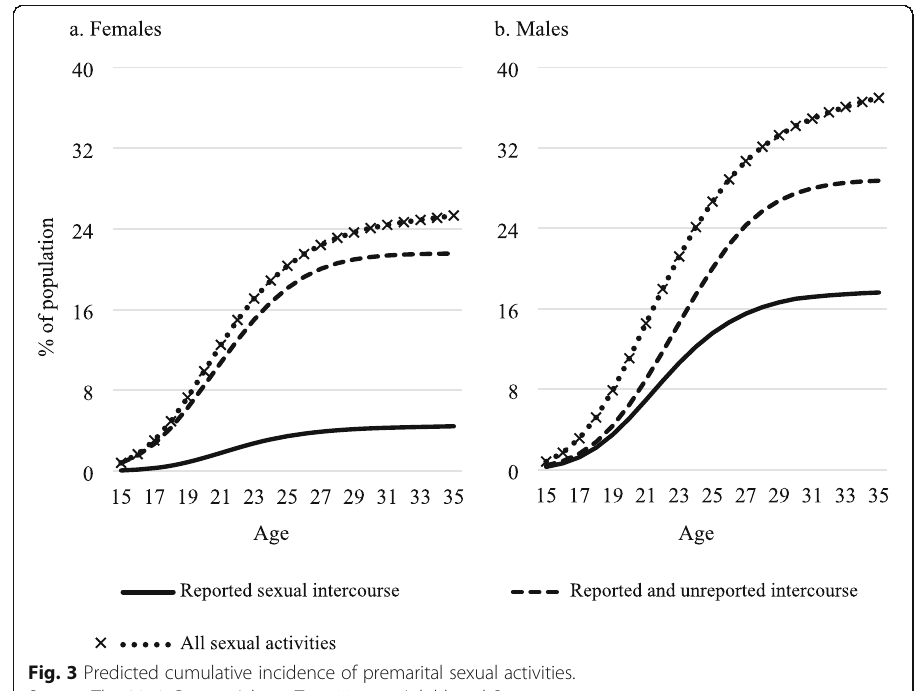
Fig. 3 Predicted cumulative incidence of premarital sexual activities. Source: The 2010 Greater Jakarta Transition to Adulthood